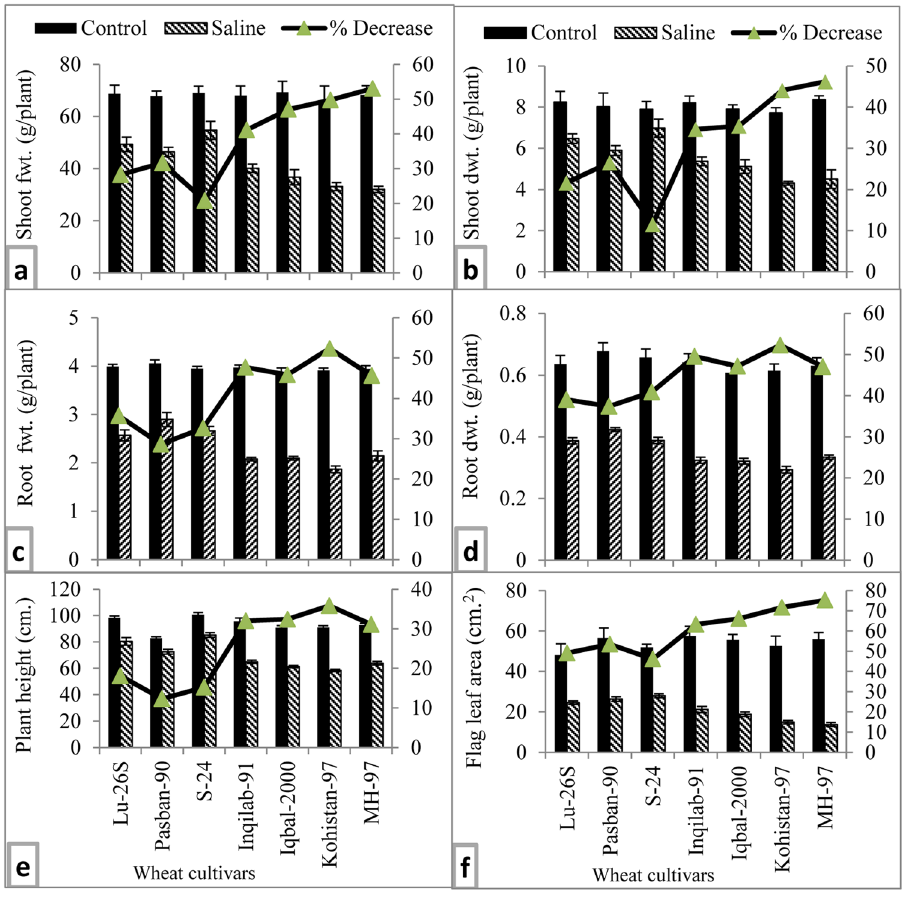
Figure 2. Growth attributes of selected salt tolerant and sensitive wheat cultivars at adult stage when plants of each cultivar were subjected to 0 or 150 mM NaCl salinity stress. Means are presented on primary vertical axis, while percent decrease value is presented on secondary vertical